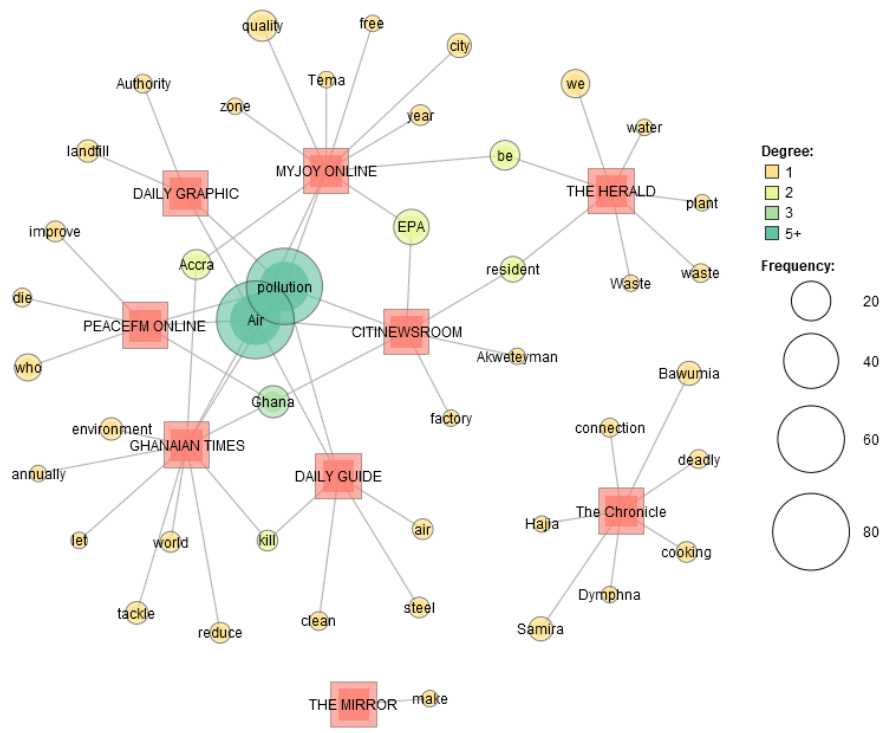
Figure 8. Semantic Network of air pollution publications by media house .